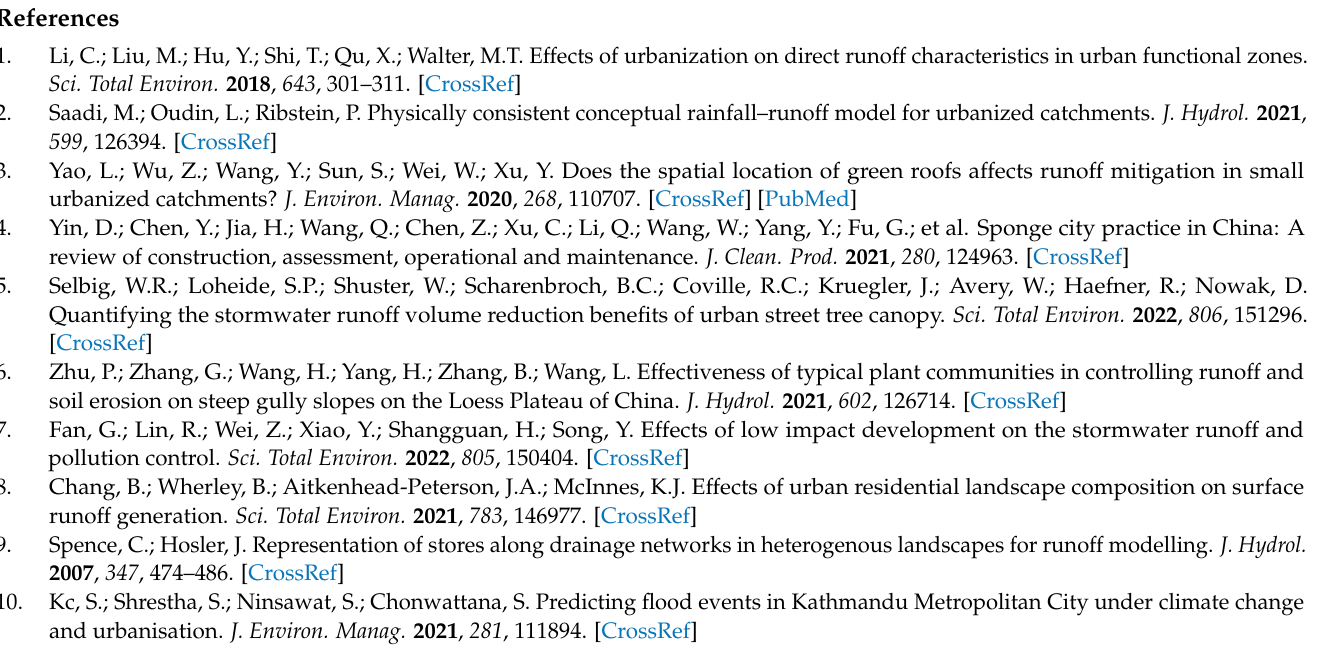
Table S1. Definitions and methods of calculating the landscape pattern indexes, Table S2. Calibrated SWMM model hydrological